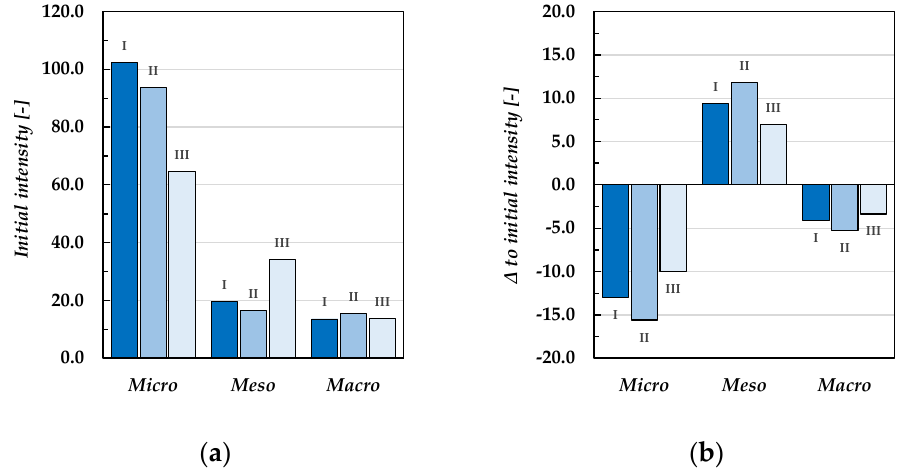
Figure 5. Initial moisture distribution from NMR measurements for three samples (I, II and III) before fatigue exposure ( a ) and redistributed moisture content from testing after stopping in phase II ( b ) for mortar of RH1 [22].